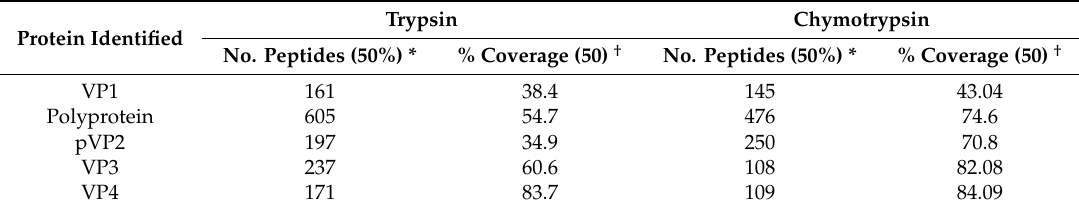
Table 1. Mass spectrometry analysis of peptides produced by digestion of ABV whole virions by trypsin or chymotrypsin. Trypsin Protein Identified